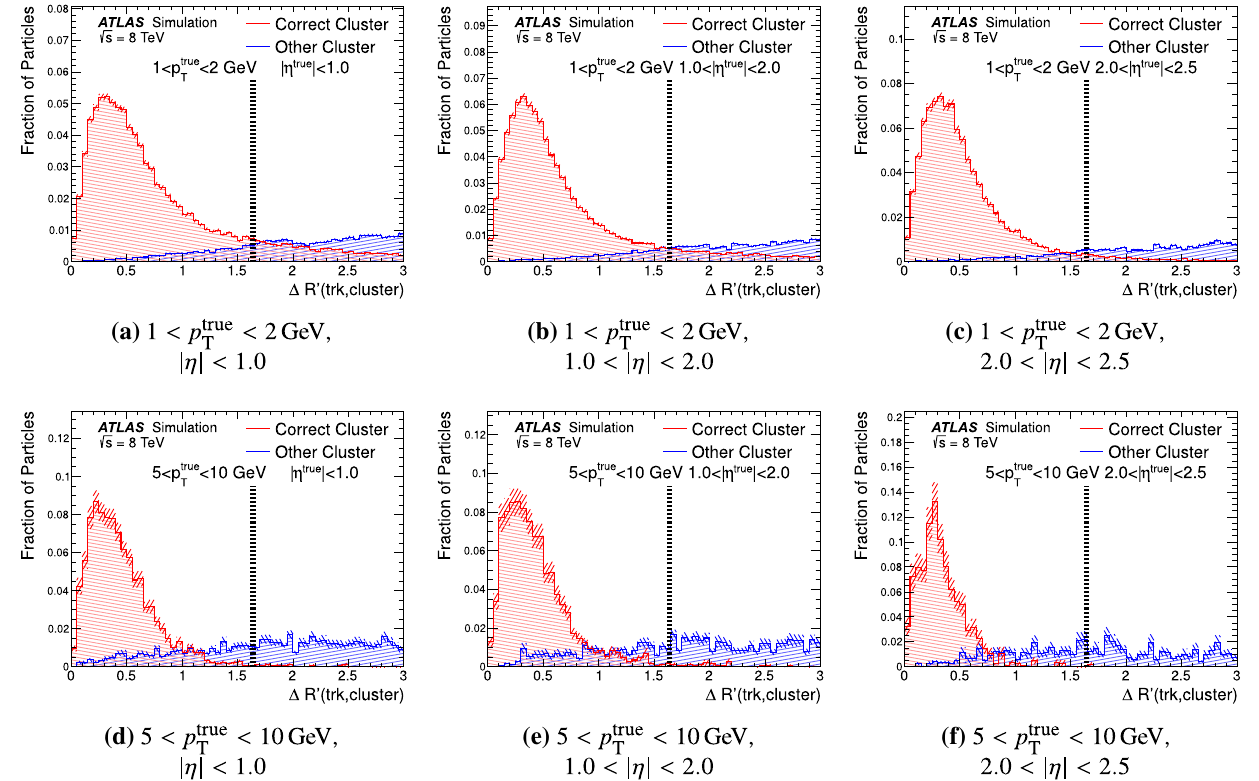
Fig. 12 The distributions of (cid:8) R (cid:8) for the topo-cluster with > 90% of tainties on the number of MC simulated events are shown as a hatched band . A track is only used for energy subtraction if a topo-cluster is the true energy of the particle and the closest other topo-cluster, both satisfying E clus / p trk > 0 . 1. The data are taken from a dijet sample found with E clus / p trk > 0 . 1 inside a cone of (cid:8) R (cid:8) < 1 . 64, as indicated < 500GeV and the statistical uncer- without pile-up with 20 < p lead by the vertical dashed line T